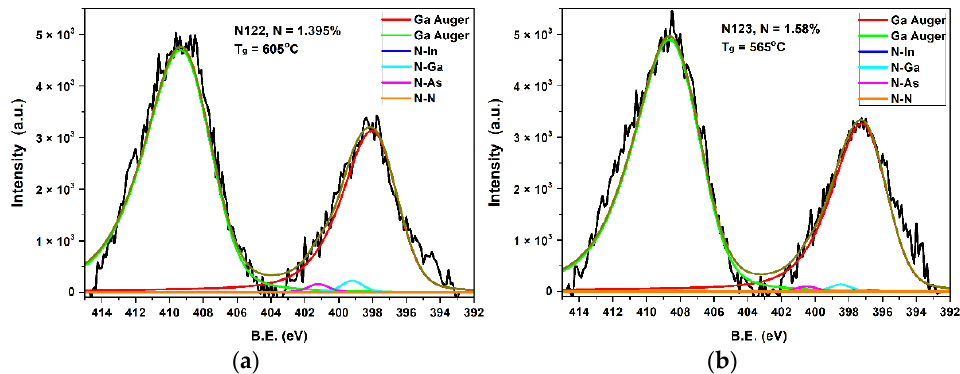
Figure 6. The N 1s core level deconvolution spectra of GaAsN/GaAs heterostructures grown: ( a ) at the highest and ( b ) lowest temperatures.